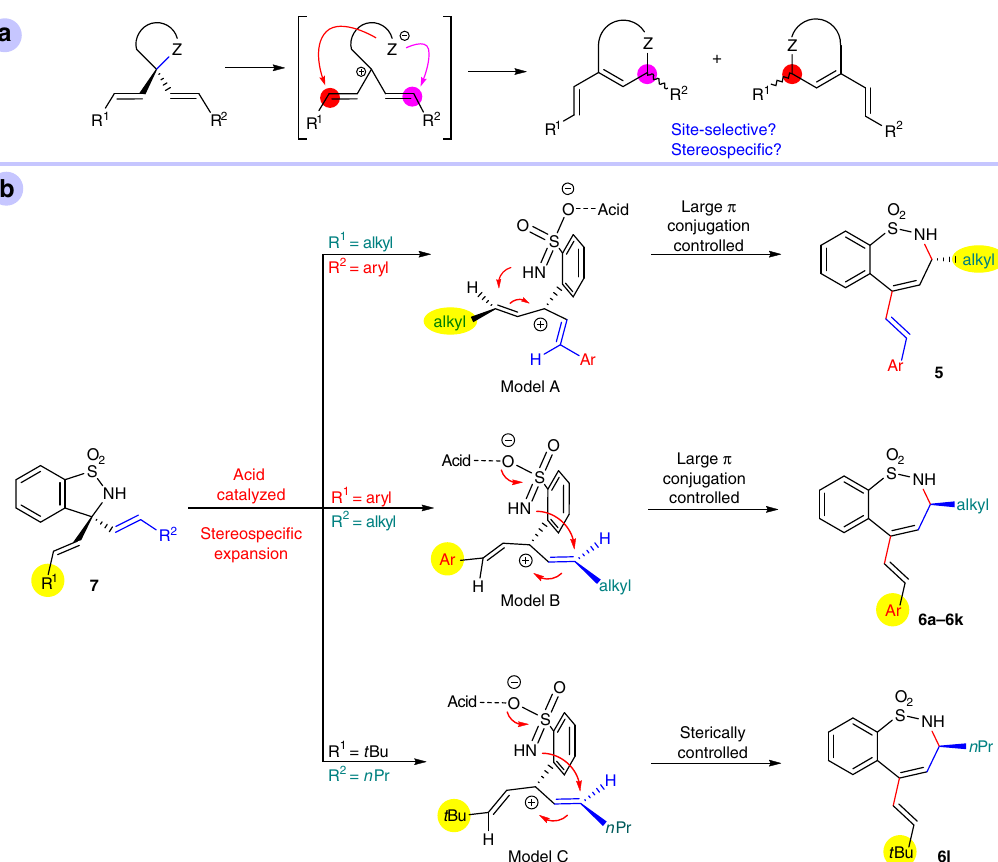
Fig. 5 Challenges for ring-expansion and proposed mechanism. a Challenges for ring-expansion of α , α -dialkenyl heterocyclic compounds bearing two different alkenyl groups. b Proposed mechanism for ring-expansion